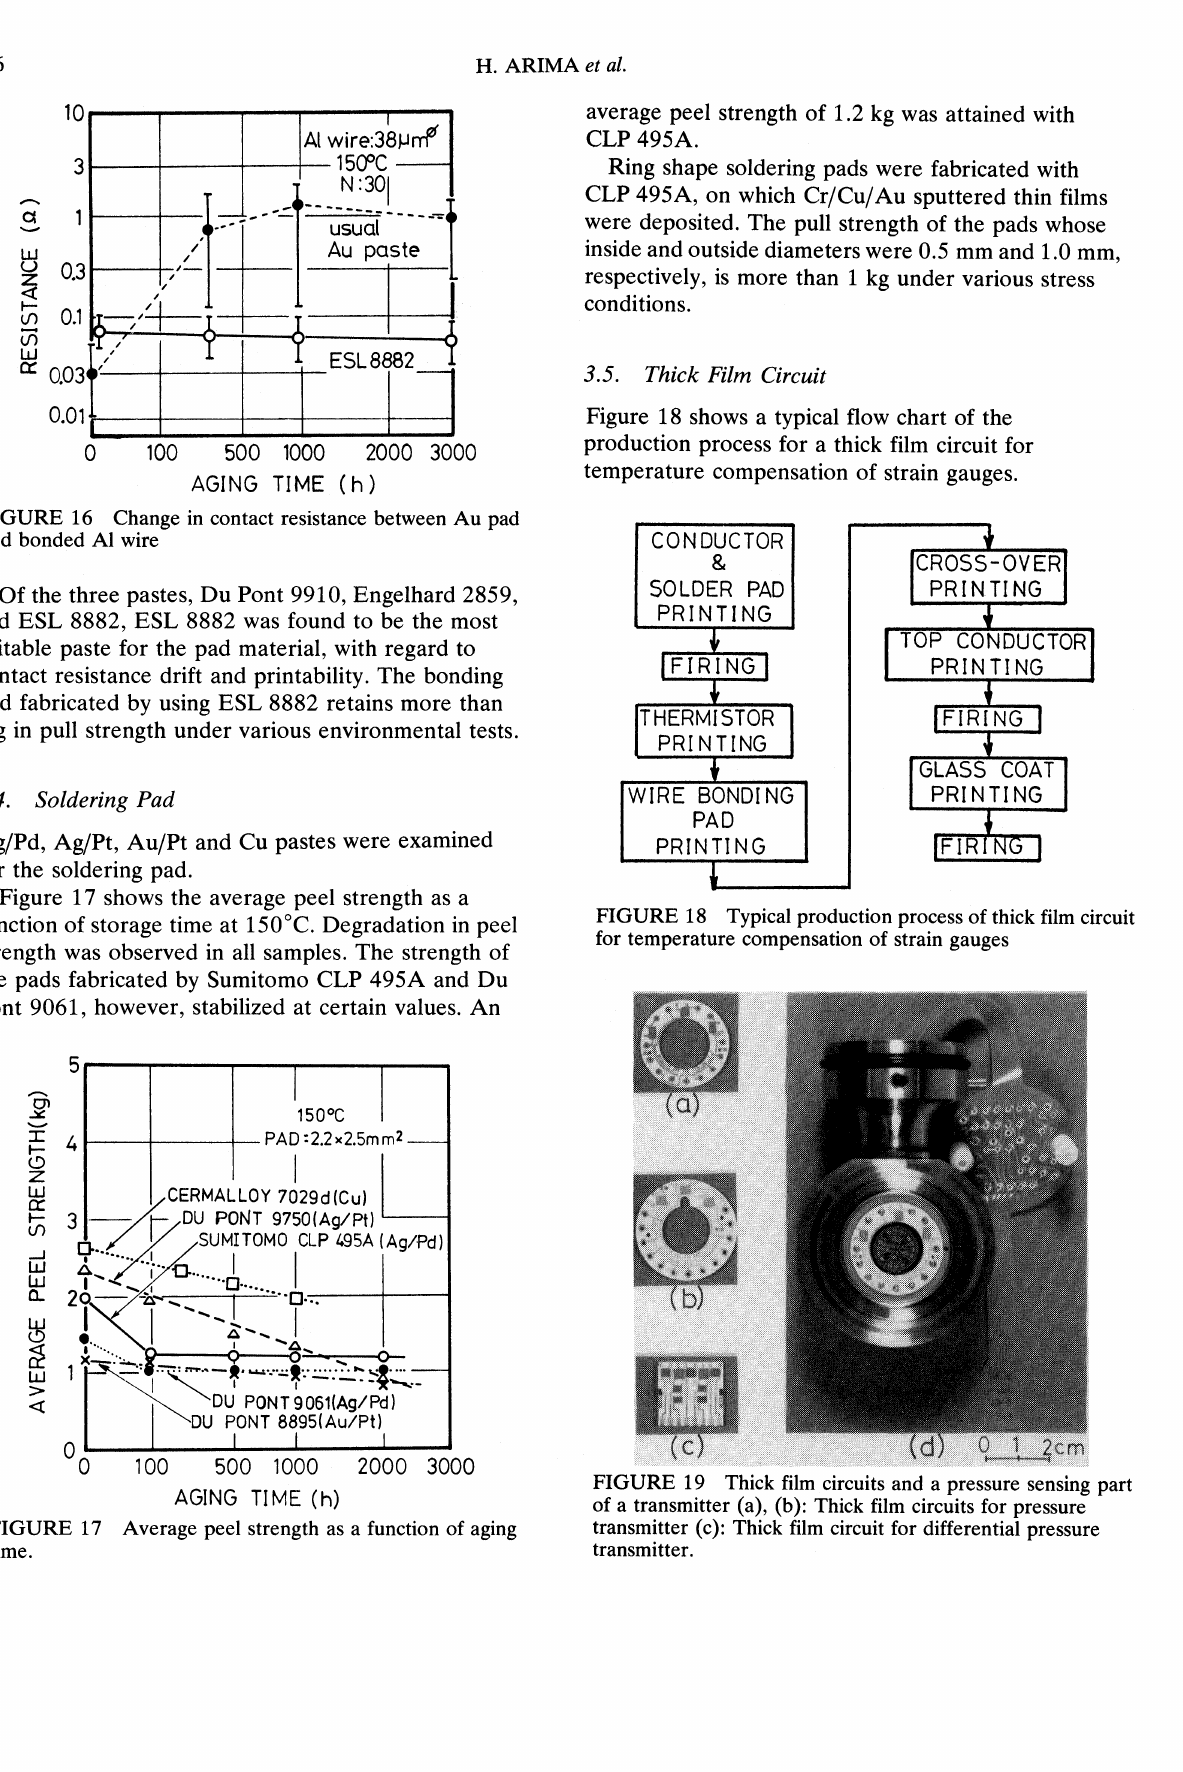
FIGURE 17 Average peel strength as a function of aging time.